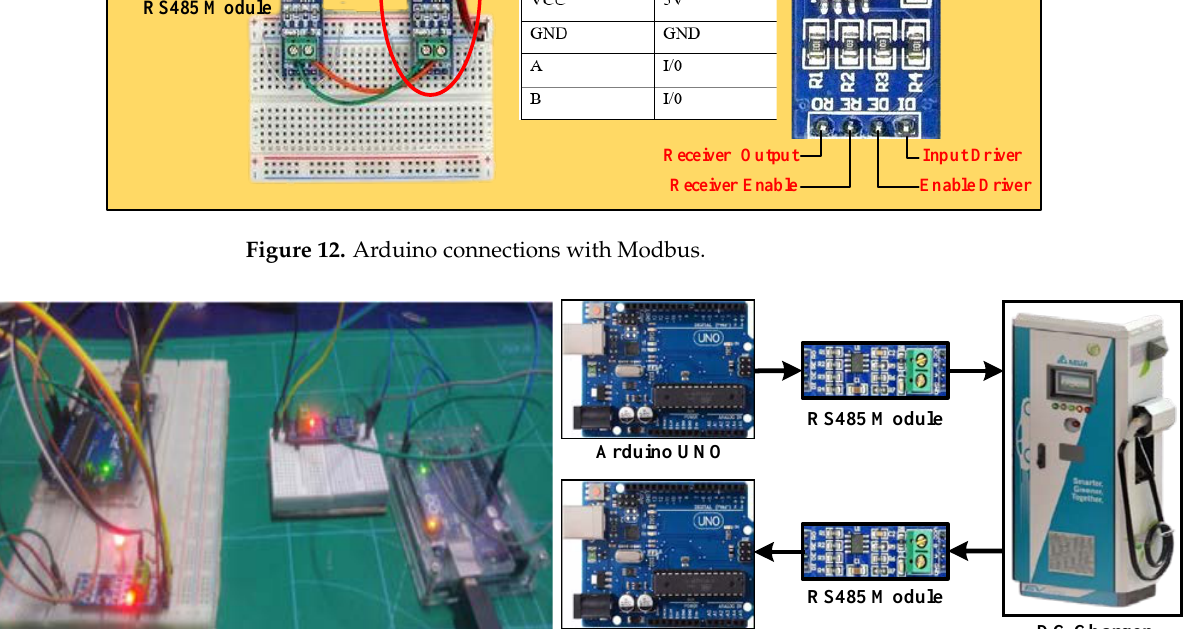
Figure 13. Implementation of communication system using MODBUS with Arduino controller.